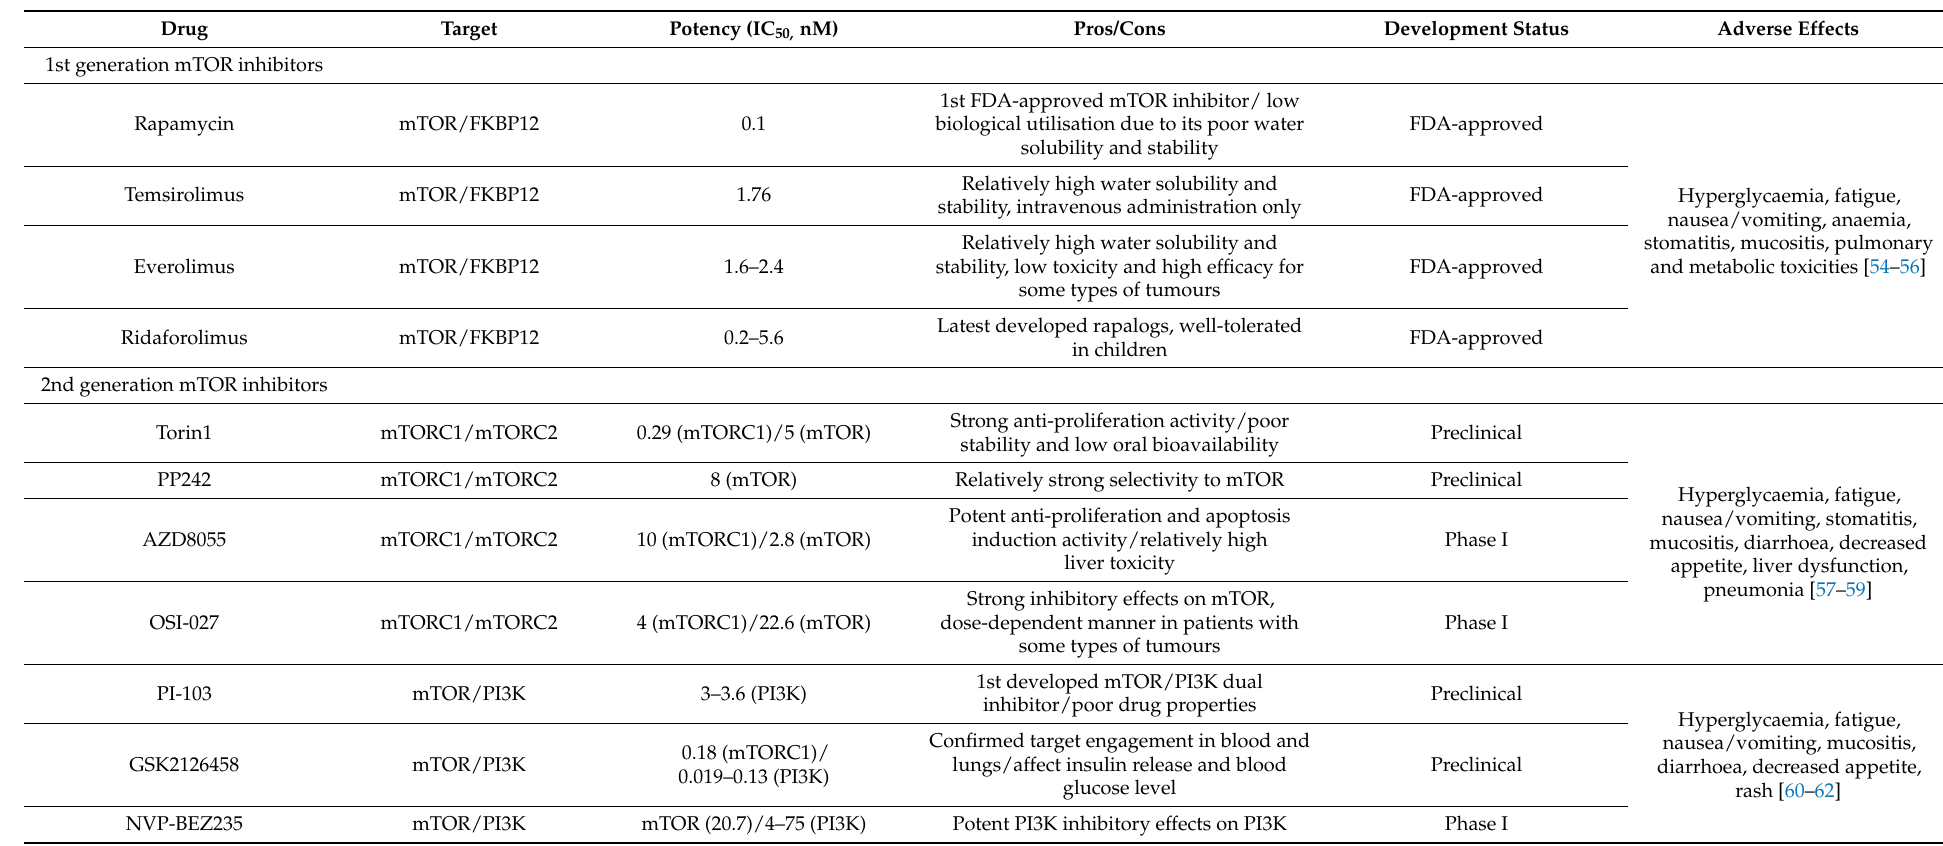
Table 1. The potency, specificity, and adverse effects of mTOR